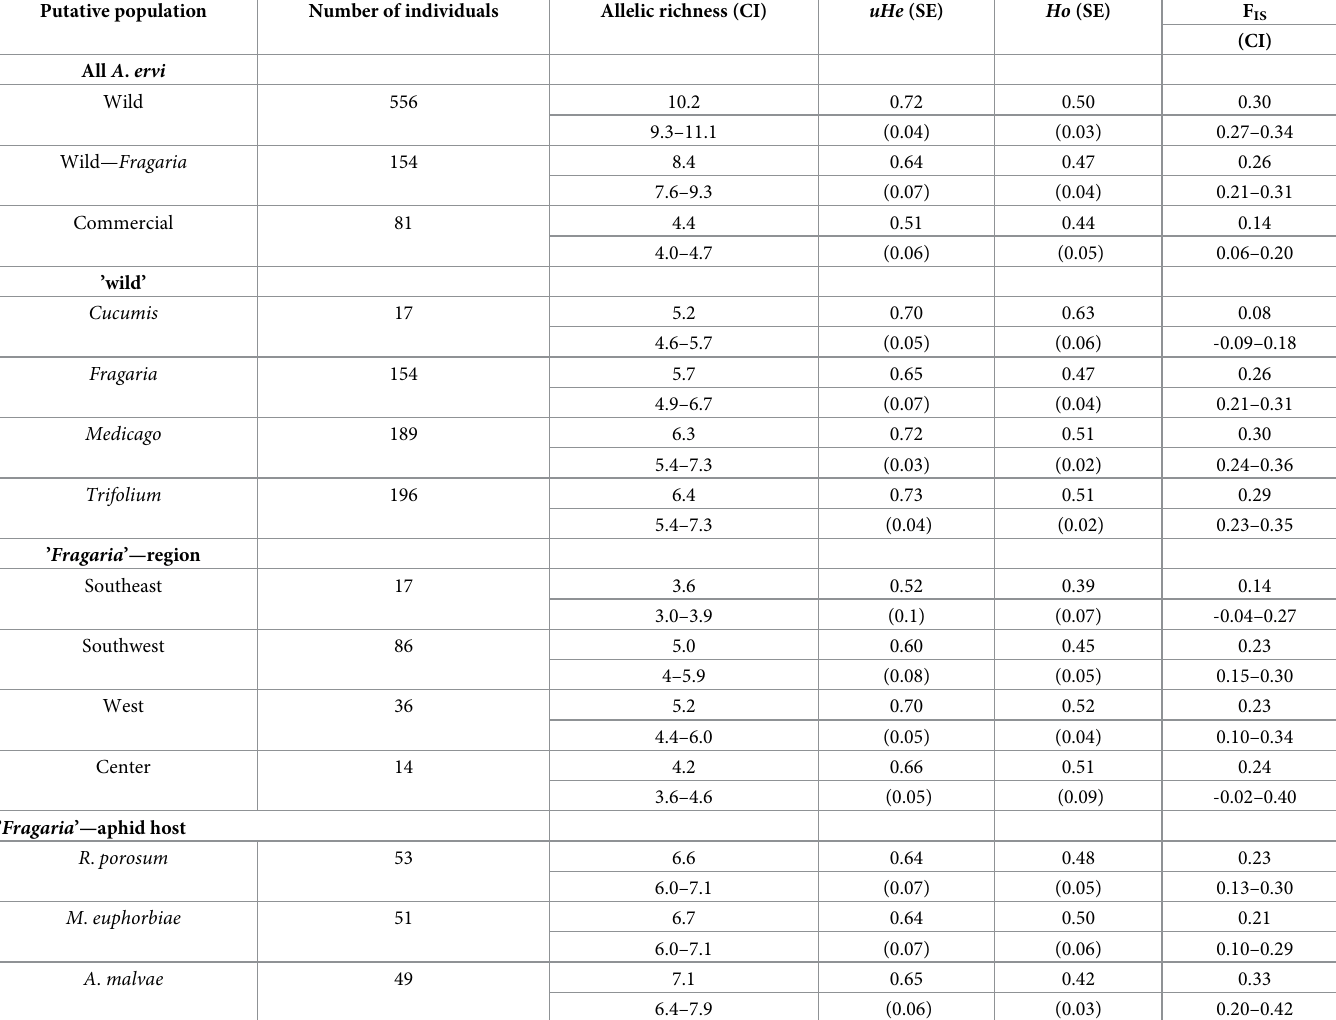
Table 2. Genetic variability of Aphidius ervi on seven microsatellite loci in each putative population and